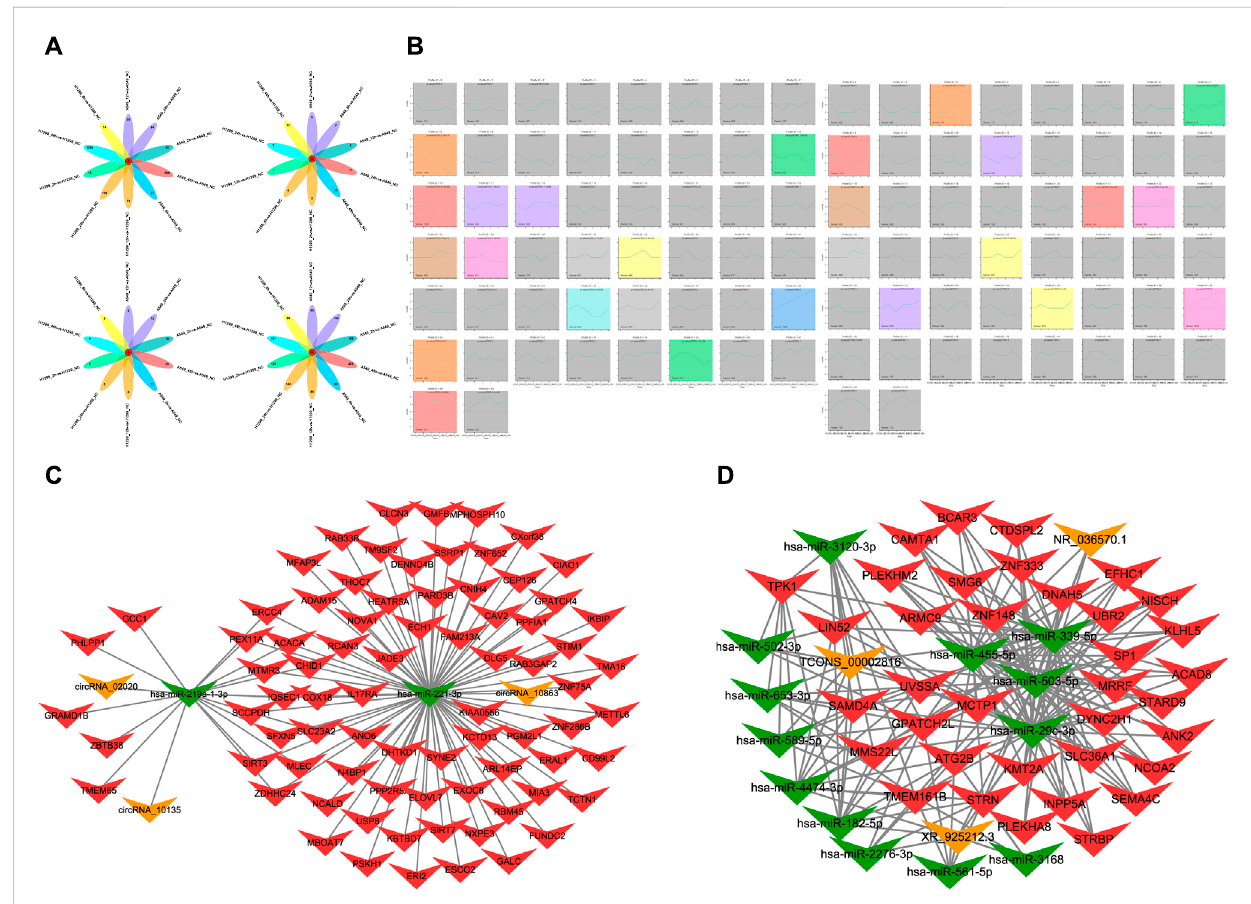
FIGURE 1 (A) Diagram of intersections in different mRNA, miRNA, lncRNA, and circRNA after radiation of A549 and H1299 cells in fi ve time points (2, 6, 12, 24, and 48 h) compared with non-irradiated cells. (B) Trend chart of mRNA after radiotherapy in A549 and H1299 cells in STEM analyses (a screenshot of the main interface window of the STEM is found in Figure 1B. In this window, each box corresponds to one of the model temporal expression pro fi les. The dataweresampledat fi vetimepoints2,6,12,24,and48 h.Thenumberatthetopofapro fi leboxisthepro fi leIDnumber.Thecoloredpro fi leshada statisticallysigni fi cantnumberofgenesassigned). (C) Signi fi cantceRNAnetworkrelatedto fi vetimepoints(2,6,12,24,and48 h)afterradiationtherapyin A549 and H1299 cells: mRNA – miRNA – circRNA network. (D) Signi fi cant ceRNA network related to fi ve time points (2, 6, 12, 24, 48 h) after